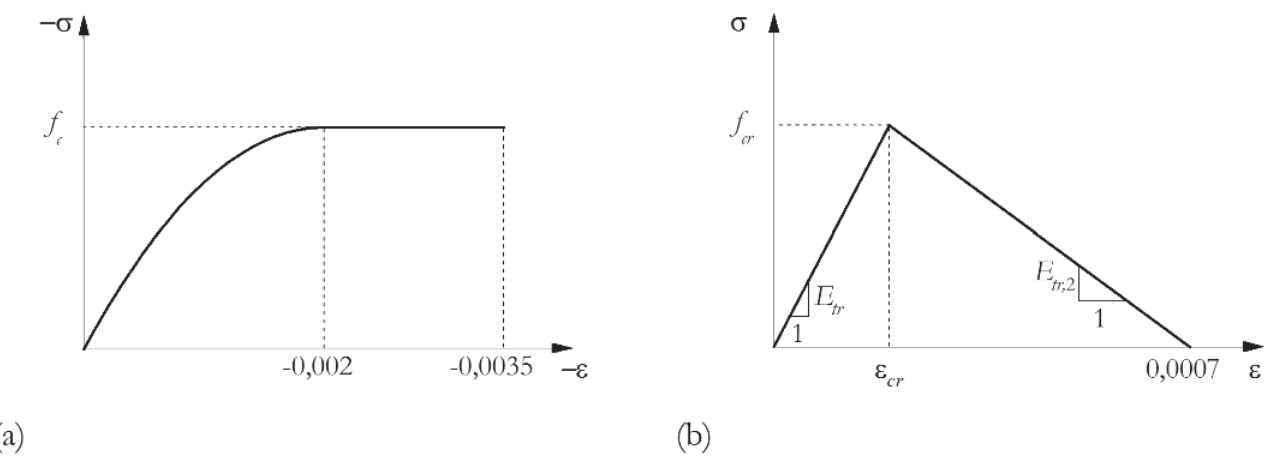
Concrete constitutive relationship (a) compression and (b)